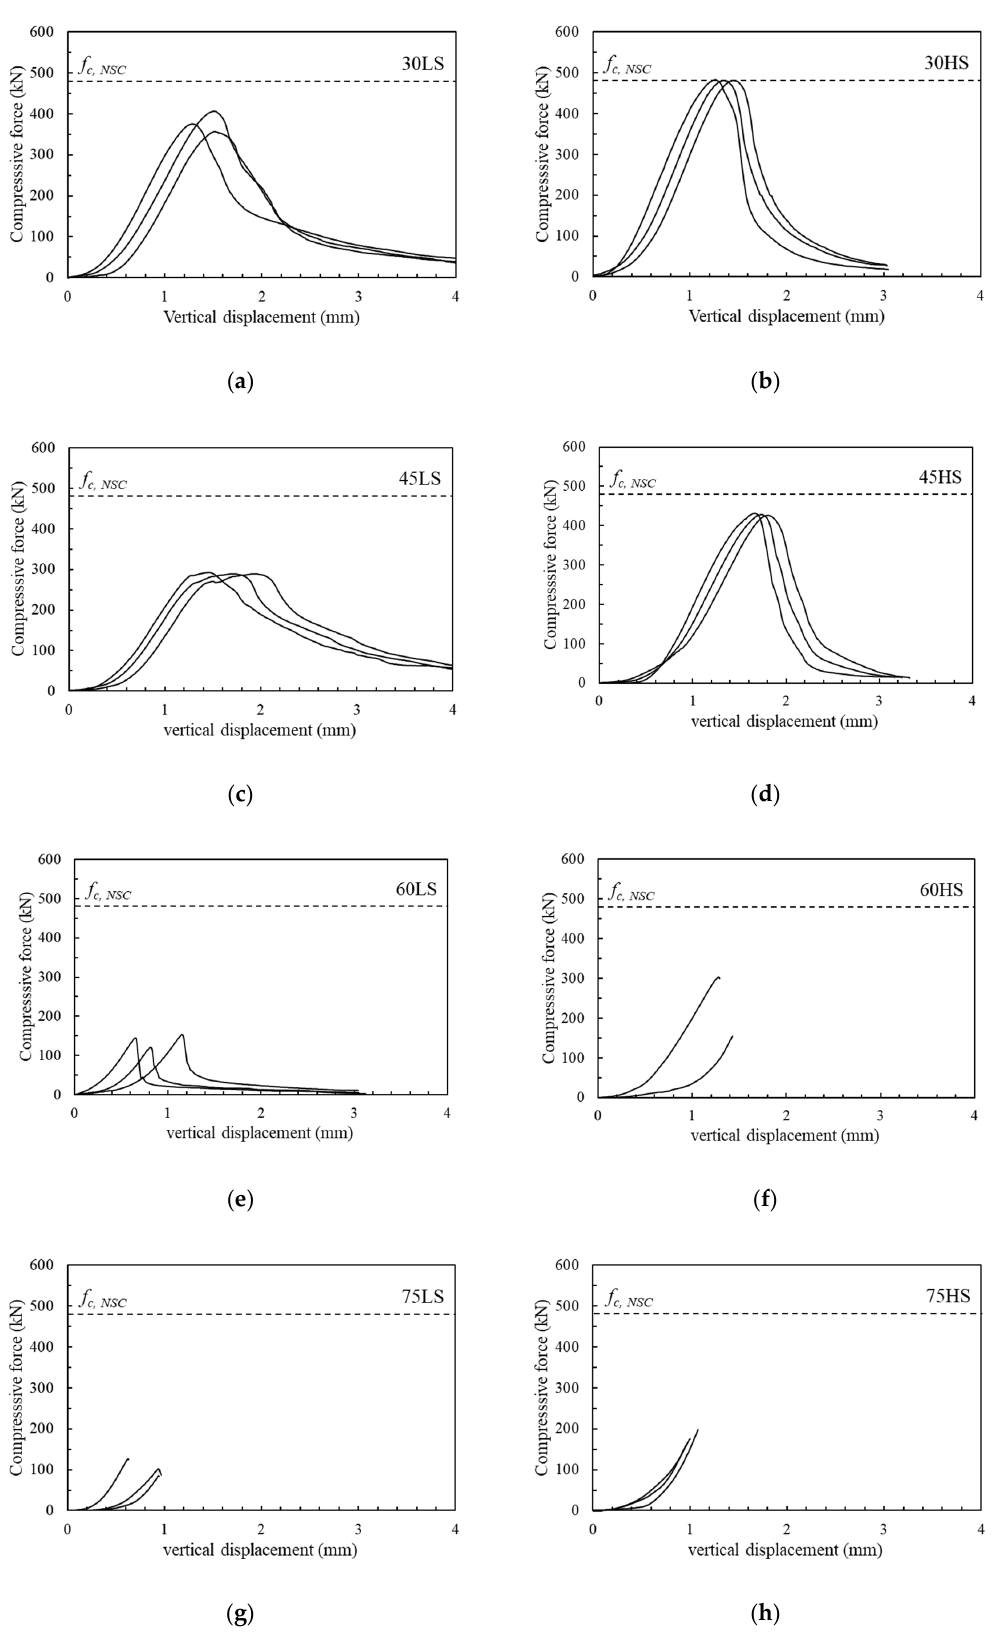
Figure 6. Load–vertical displacement behavior of slant shear strength test: ( a ) 30LS; ( b ) 30HS; ( c ) 45LS; ( d ) 45HS; ( e ) 60LS; ( f ) 60HS; ( g ) 75LS; ( h )